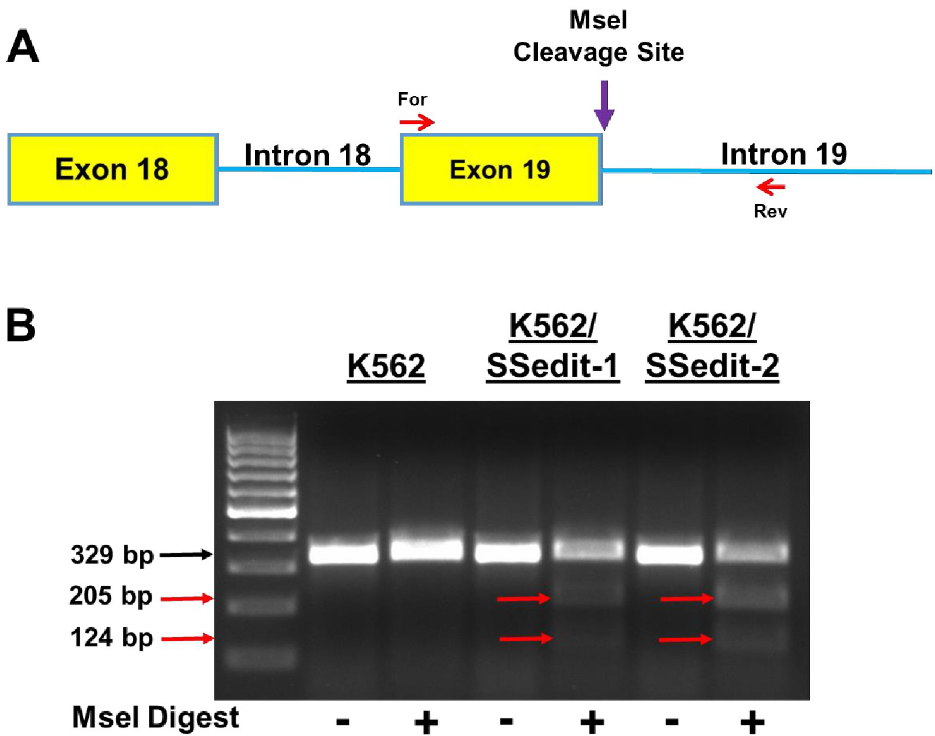
Fig 4. MseI validation of CRISPR/Cas9 edited TOP2 α E19/I19 5 0 SS clonal cell lines. (A) Schematic representation of the E18 through I19 portion of the TOP2 α gene. Red arrows denote the forward and reverse primers used for the identification of CRISPR editing of the TOP2 α E19/I19 5 0 SS using MseI endonuclease (T # TAA) . The purple arrow denotes site where MseI creates double strand breaks of the CRISPR-edited PCR amplicon. (B) Ethidium bromide- stained agarose gel of fractionated MseI-treated PCR amplicons from K562, K562/SSedit-1 and K562/SSedit-2 cells DNA. The black arrow denotes the parental PCR amplicon. Expected sizes of daughter PCR amplicons are indicated by red